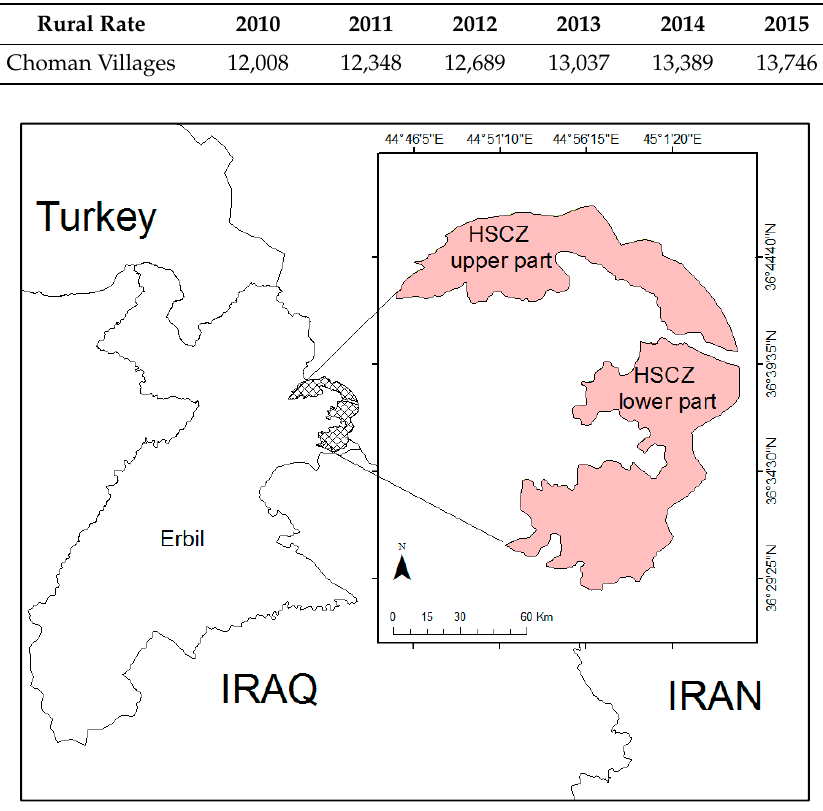
Figure 1. Location map of the study area (HSCZ) in the Kurdistan Region of Iraq.